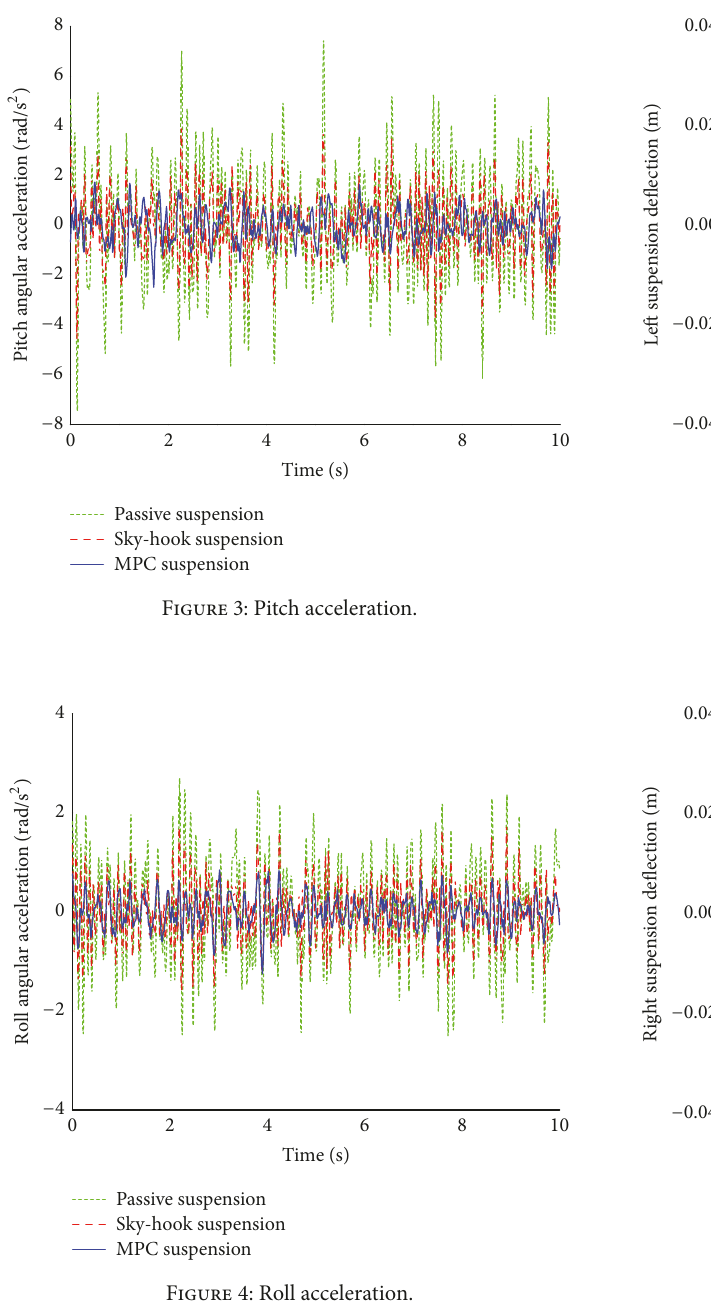
Figure 6: Deflection of the suspension